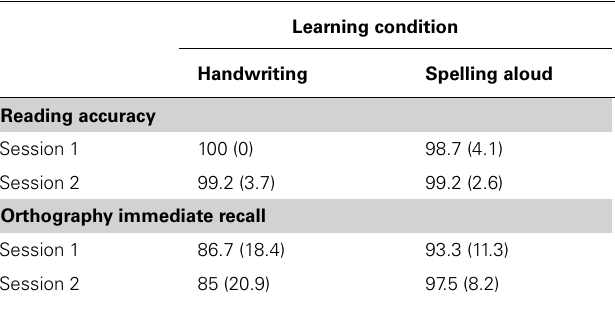
Table 2 | Experiment 1. Mean target reading accuracy and mean accurate orthography immediate recall (Percentage and standard deviation) during the handwriting and spelling-aloud learning conditions for each session.